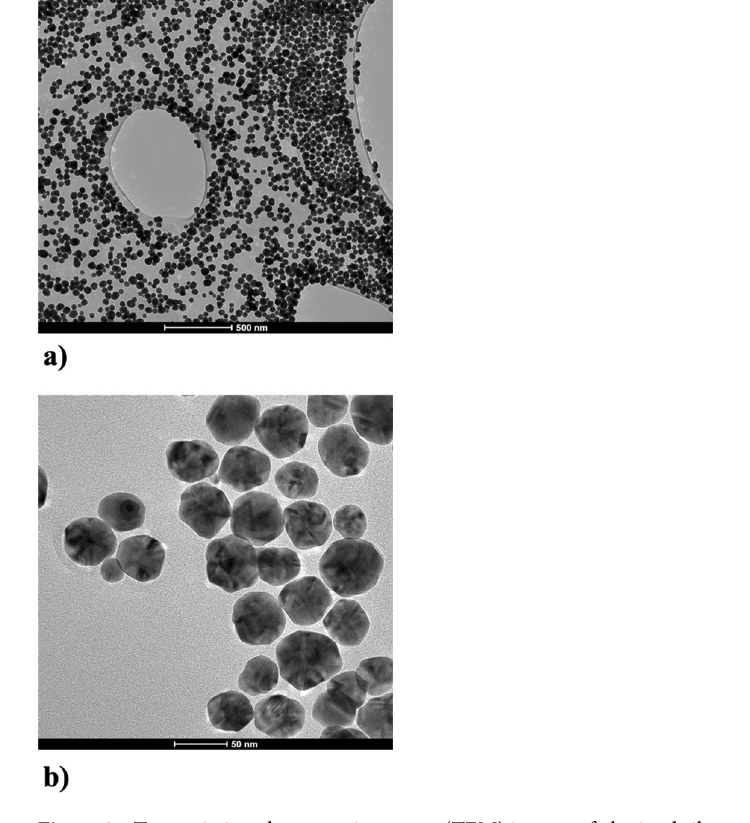
Figure 8. Transmission electron microscopy (TEM) images of obtained silver nanoparticles (Ag